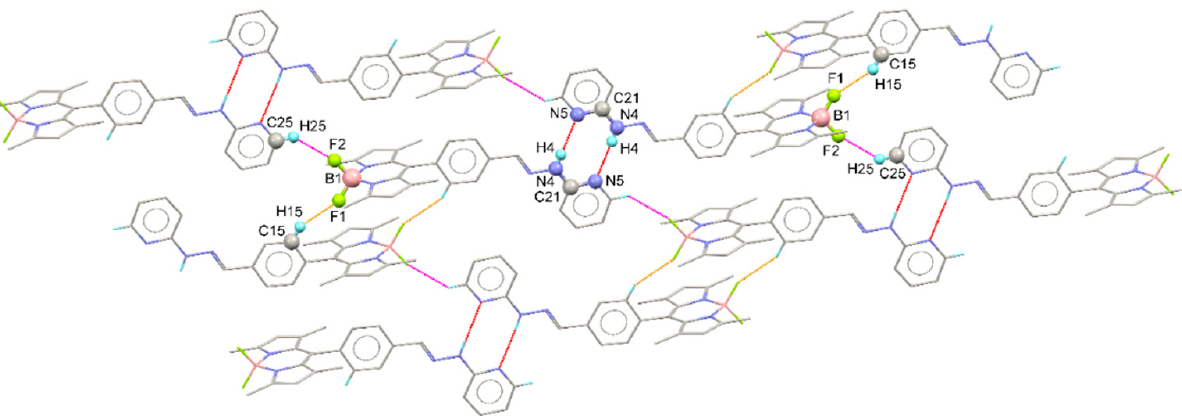
Figure 3. Views of the crystal packing which illustrate the R 22 (8) N—H · · · N hydrogen bonding loop (red dash lines) as well as the C—H · · · F interactions (orange and magenta dash lines) in the extended structure of BODIPY-PH.